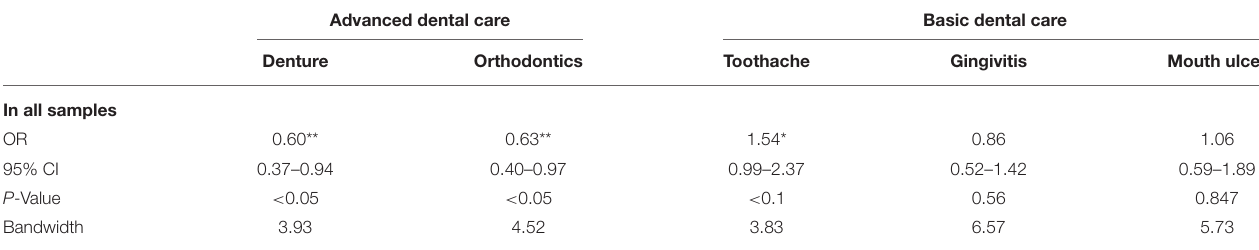
TABLE 3 | Regression continuity estimates of COVID-19 on five dental care searching